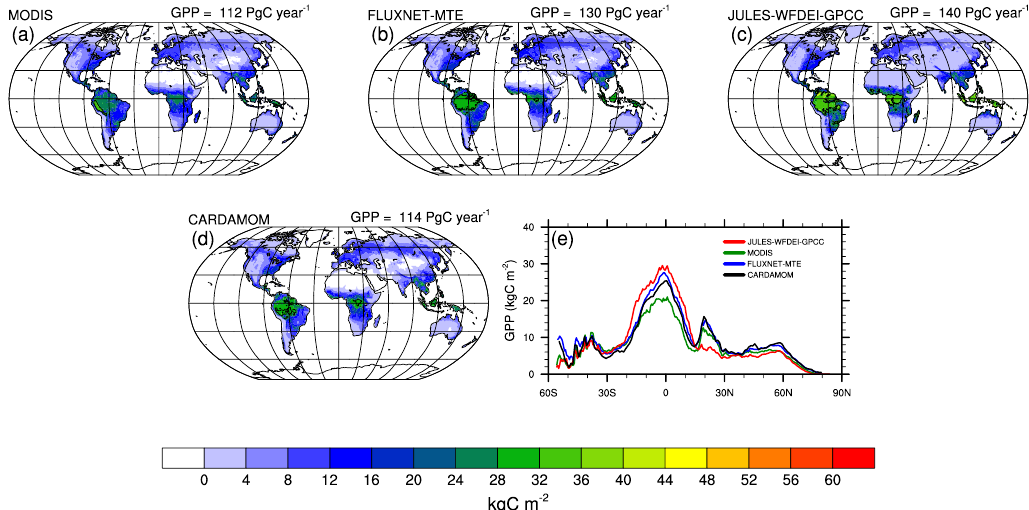
Figure 2. Total annual and zonal mean model-simulated (JULES-WFDEI-GPCC), observed (FLUXNET-MTE and MODIS) and CAR- DAMOM GPP fluxes for the 2001–2010 period on the global scale. JULES, FLUXNET-MTE and MODIS GPP are at 0 . 5 ◦ × 0 . 5 ◦ spatial resolution and CARDAMOM is at 1 ◦ × 1 ◦ resolution. Panels (a) , (b) , (c) and (d) show the total annual GPP of JULES-WFDEI-GPCC, FLUXNET-MTE, MODIS and CARDAMOM GPP, respectively. At the top right of each map subplot, the average global annual GPP for 2001–2010 is displayed. Panel (e) shows the zonal mean of the total annual JULES-WFDEI-GPCC, FLUXNET-MTE, MODIS and CAR- DAMOM GPP, respectively. Included in each map subplot are contour lines for the tropical regions.